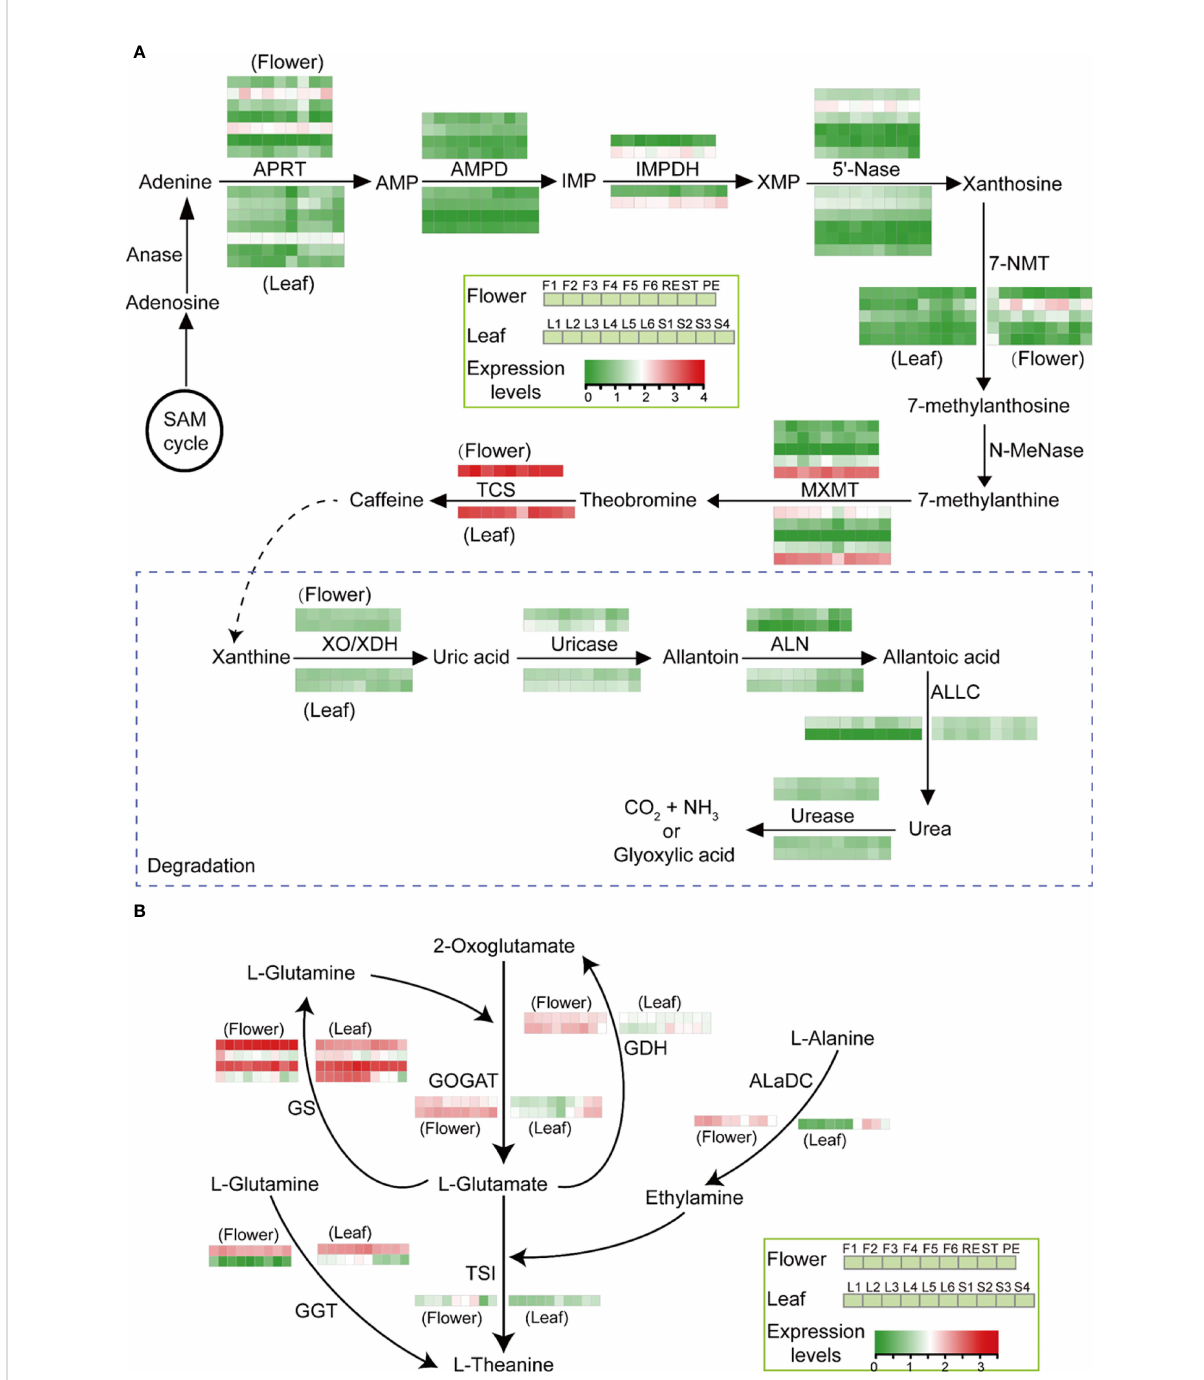
FIGURE 7 Caffeine and theanine biosynthesis in tea fl owers. (A, B) Main biosynthetic route toward caffeine biosynthesis and degradation (A) and theanine biosynthesis (B) in tea developing fl owers and leaves. AMP, adenosine monophosphate; IMP, inosine monophosphate; XMP, xanthosine monophosphate; Anase, adenosine nucleosidase; APRT, adenine phosphoribosyltransferase; AMPD, AMP deaminase; IMPDH, IMP dehydrogenase; 5 ′ -Nase, 5 ′ -nucleotidase; 7-NMT, 7-methylxanthosine synthase; N-MeNase, N-methylnucleotidase; MXMT, theobromine synthase; TCS, tea caffeine synthase; XO, xanthine oxidase; XDH, xanthine dehydrogenase; ALN, allantoinase; ALLC, allantoicase; GS, glutamine synthetase; GOGAT, glutamate synthase; GDH, glutamate dehydrogenase; AlaDC, alanine decarboxylase; GGT, g -glutamyltranspeptidase; TSI, theanine synthetase. The log 10 (expression levels, TPM) of the genes is represented by a heat